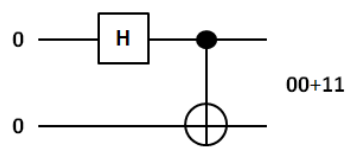
Figure 1 . The standard Hadamard entangler